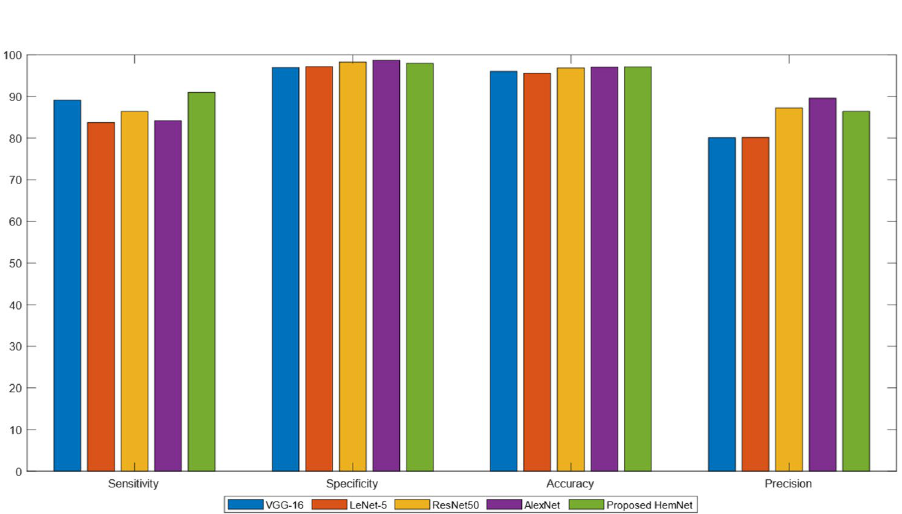
Table 3. Classification of HEs using various models on the DIARETDB0 dataset.